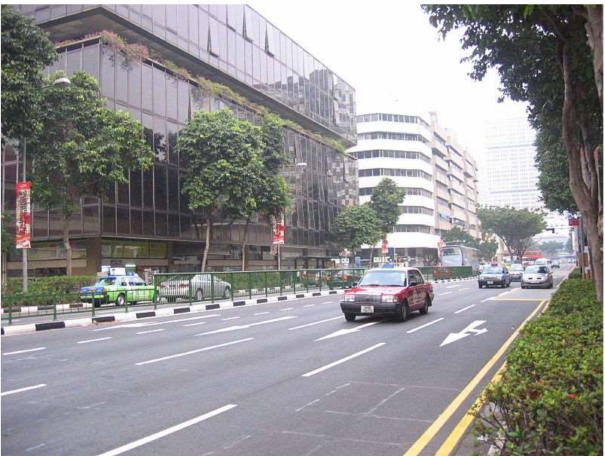
Figure 4. Modern-day Middle Road (Terence Ong, https: // commons.wikimedia.org / wiki / File:Middle_R